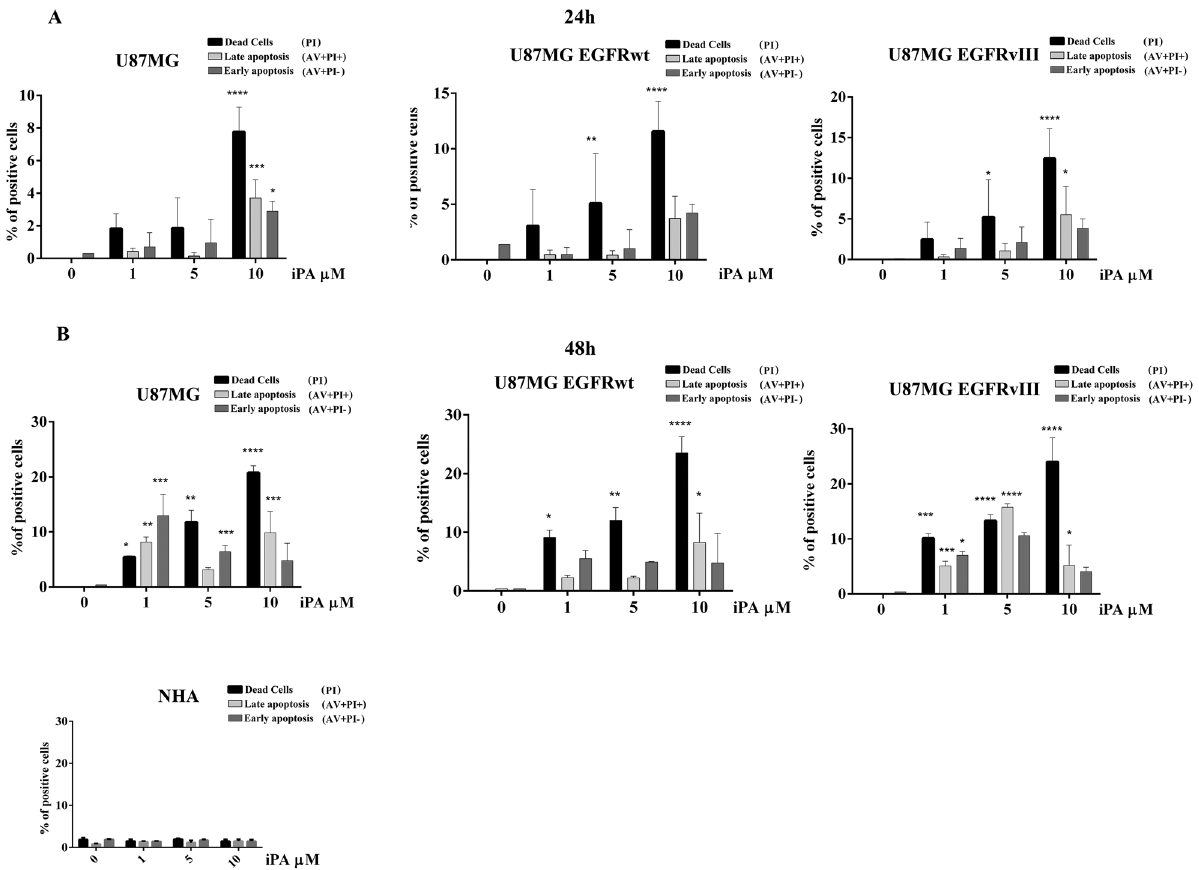
Fig. 2 iPA induces cell death. GBM stabilized cell lines and normal control NHA cells were treated with 1, 5, and 10 µM of iPA for 24 h ( A ) and 48h ( B ). Cell death was determined by fl ow cytometry followed by Annexin V/PI staining. Early Apoptosis: Annexin V-positive cells (AV + /PI − ); Necrosis: PI-positive and Annexin V-negative cells (AV − /PI + ); and Late apoptosis (AV + /PI + ). The data are presented as mean ± SD of at least three independent experiments. * p < 0.05, ** p < 0.01, *** p < 0.001, **** p < 0.0001 versus control, represented by cells treated with vehicle